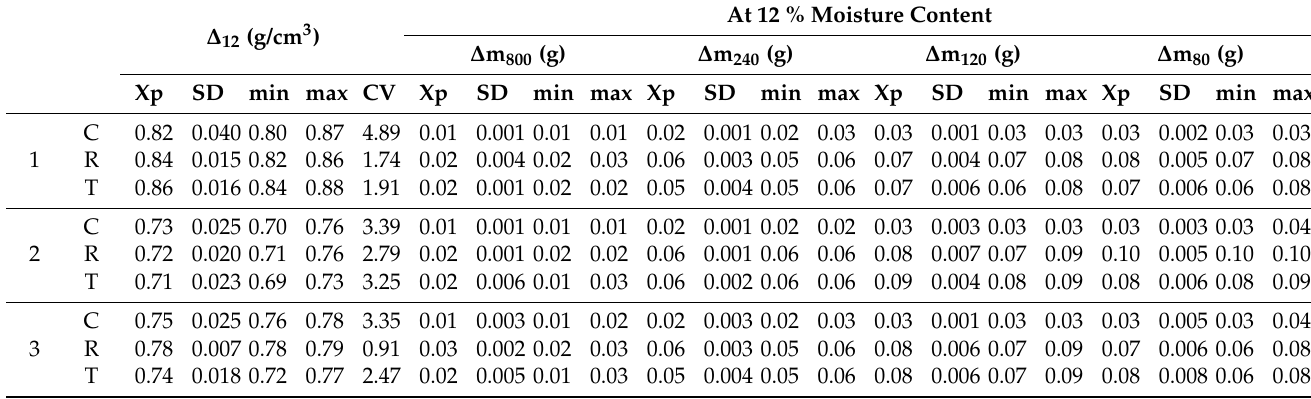
Table 3. The density at 12% moisture content ( ρ 12 ) of oak wood samples and the mass loss ( ∆ m) in three characteristic sections recorded on four grades of sandpaper (P80, P120, P240, P800).